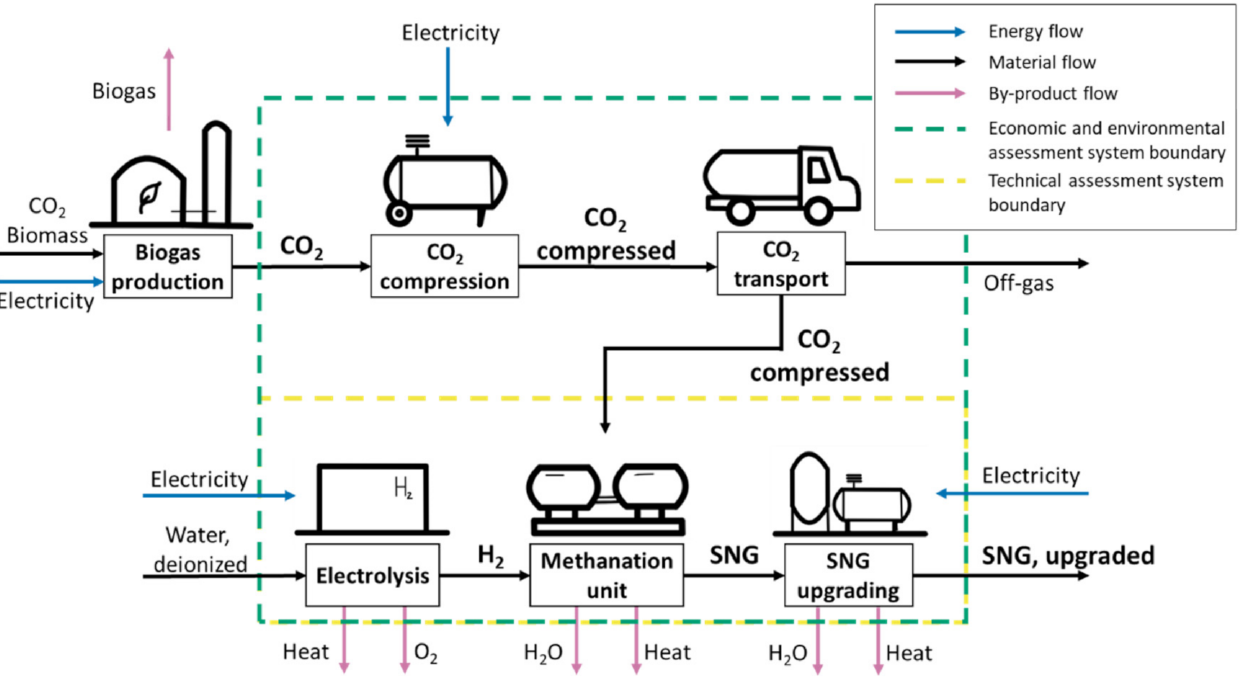
Figure 1. Schematic representation of considered system boundaries for the technical, economic and environmental assessment in the Reference